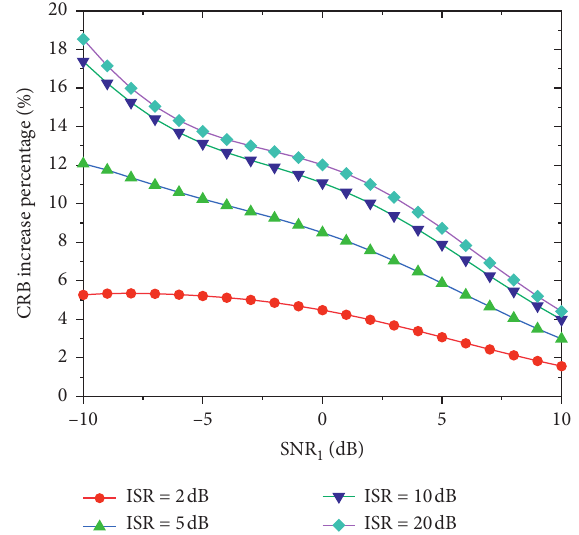
Figure 5: The increase percentage of the CRB of the weak source against the ISR under different SNR 1 .